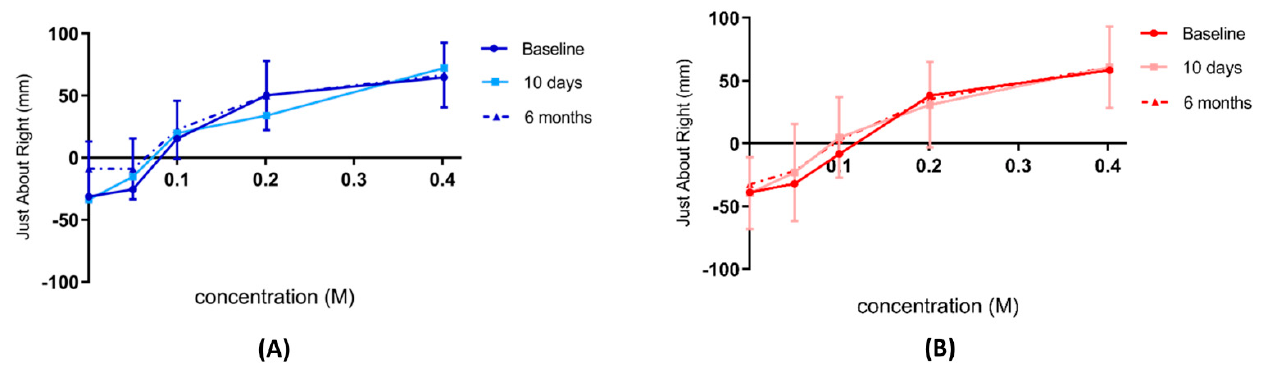
Figure 5. Just About Right scale ratings of sweet taste. Consummatory reward value of sweet taste assessed by Just About Right scale for ( A ) controls n = 19 (blue) and ( B ) Endobarrier n = 24 (red groups). Data are presented as the mean rating at each concentration ± SD.